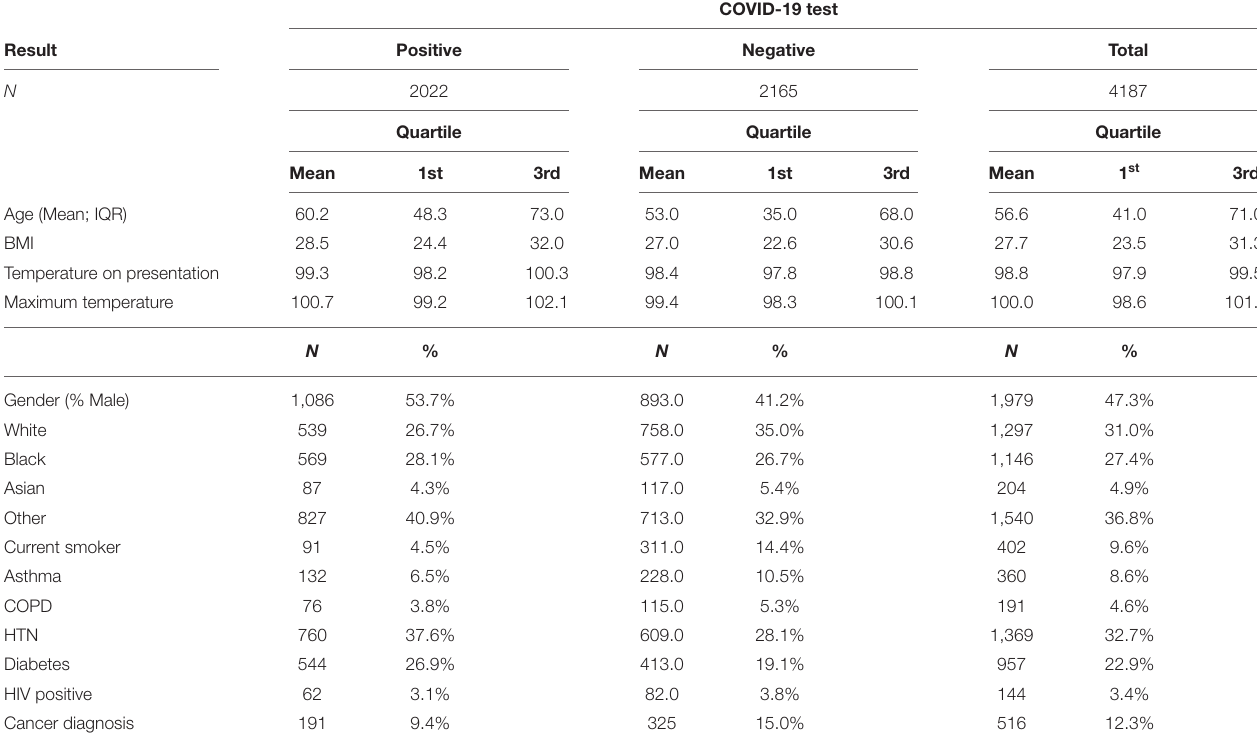
TABLE 1 | Characteristics of all patients; subdivided by the result of Covid-19